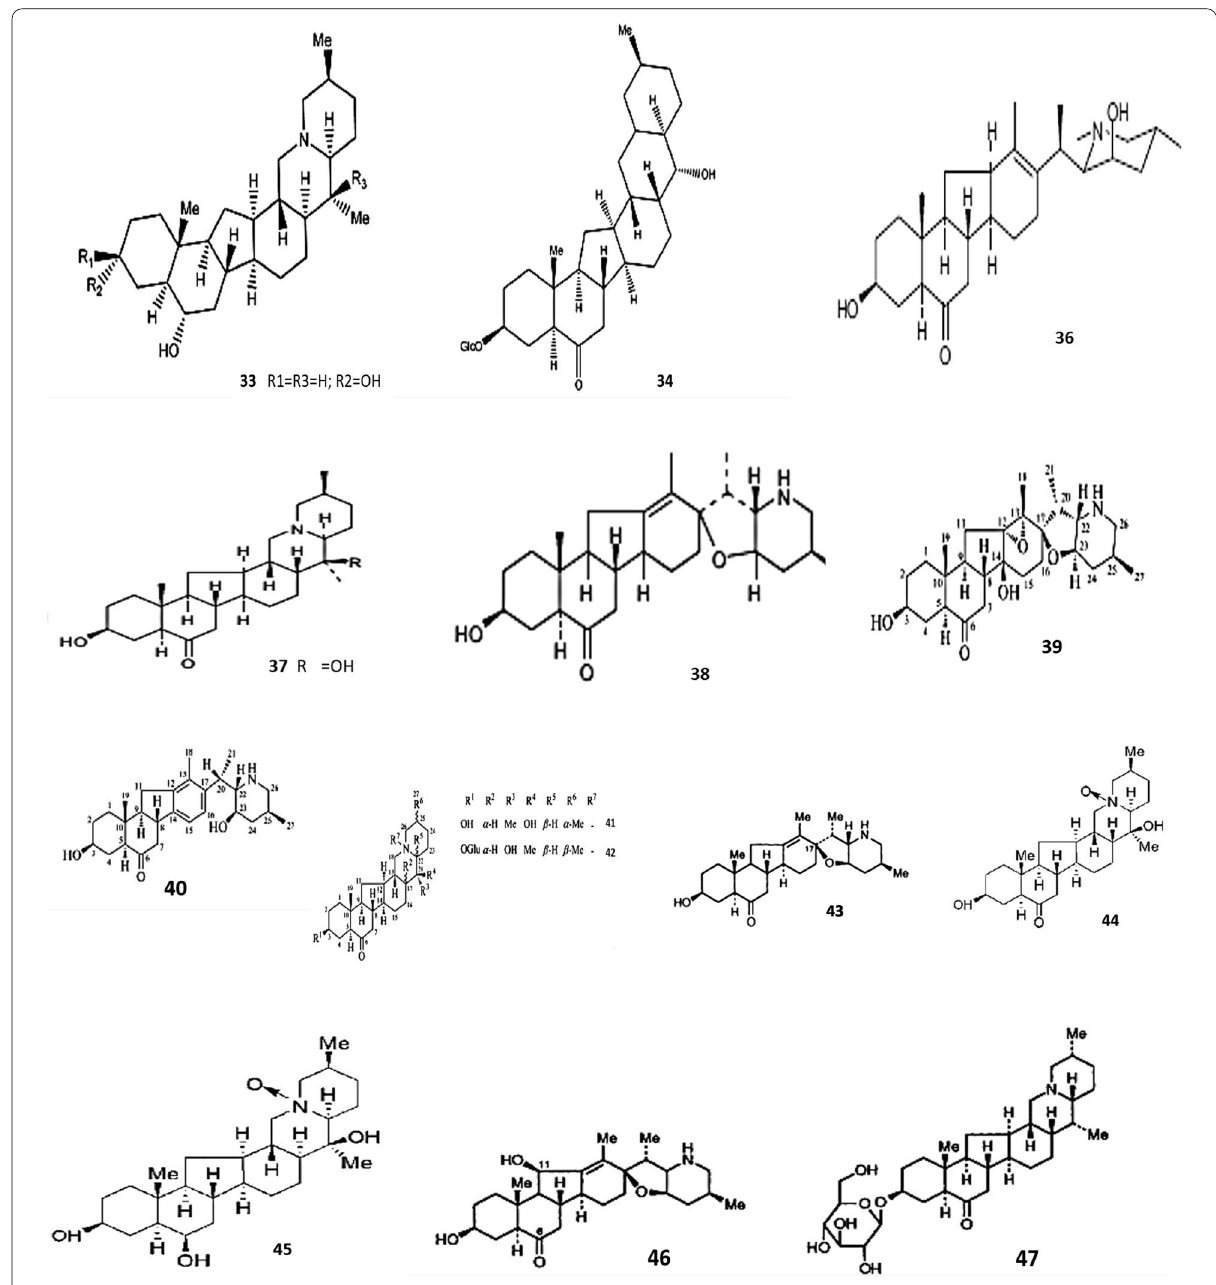
Phytochemical investigation on Fritillaria pallidiflora has revealed the isolation of steroidal alkaloids (Xu et al. 1993; Li et al. 2002) and nonsteroidal alkaloids. Steroidal alkaloids like yibeinine (31) (Xu et al. 2014), yubeinine (32) (Zhang et al. 1993d), peimine (22) (Li and Wu